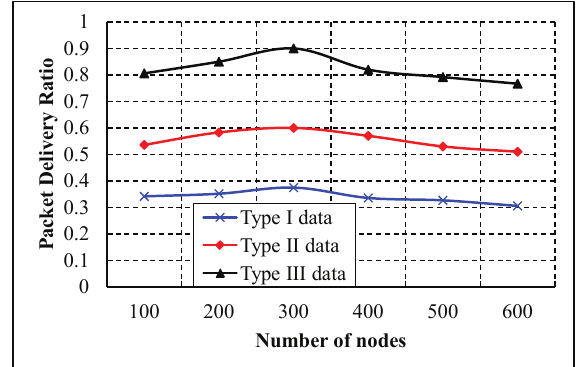
Figure 22. Average packet delivery ratios for different data types with eight